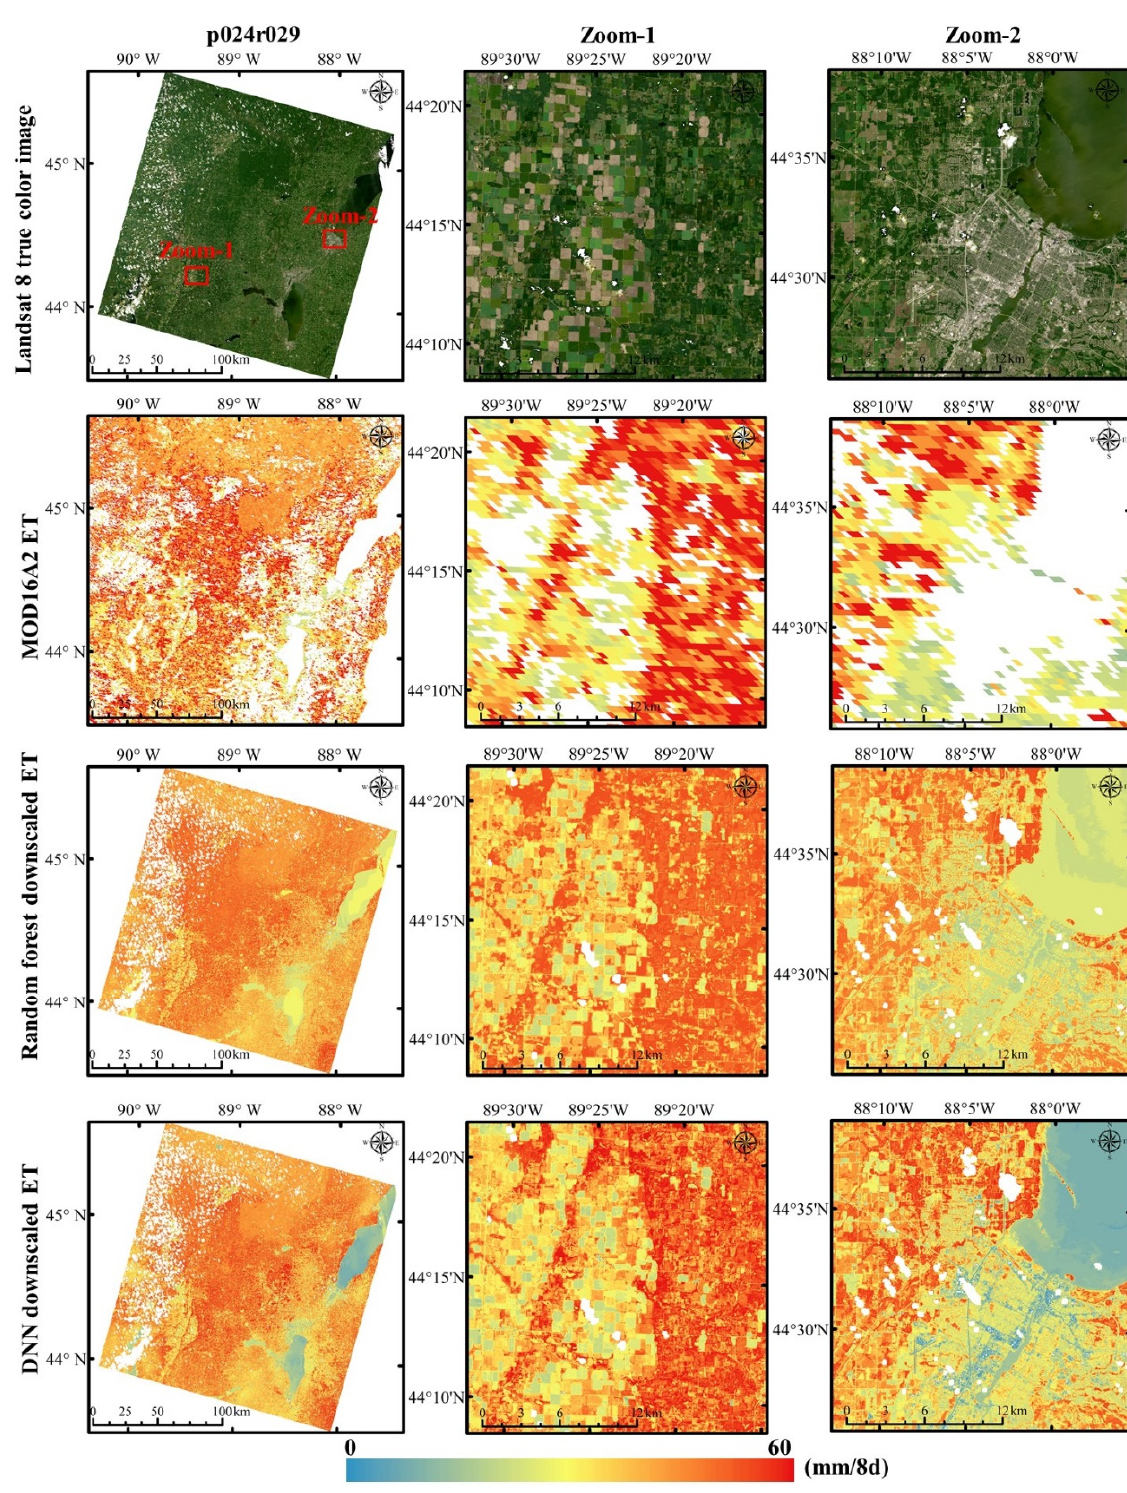
Figure 6. Same as Figure 4 but for the p024r029 region with Landsat 8 image acquired on 27 August 2019.